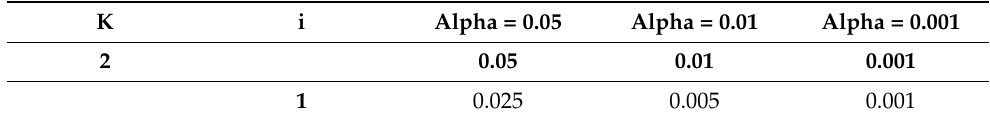
Table 6. Benjamini–Hochberg correction: comparison of microRNA gene expression between GDM and normal term pregnancies.